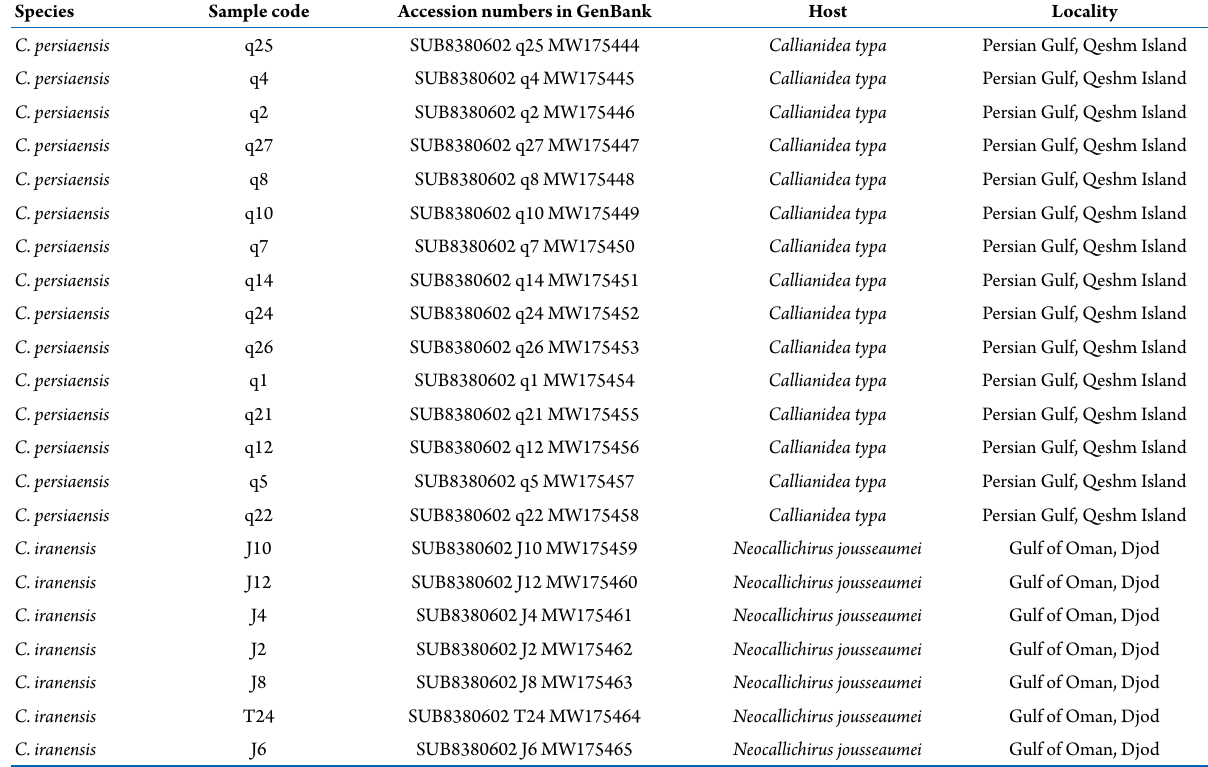
Figure 2. Map of sampling stations in the Persian Gulf and the Gulf of Oman. Table 1. Sequence accession numbers in NCBI, host of Clausidium copepods, and locality of sample collection. Species Sample code Accession numbers in GenBank